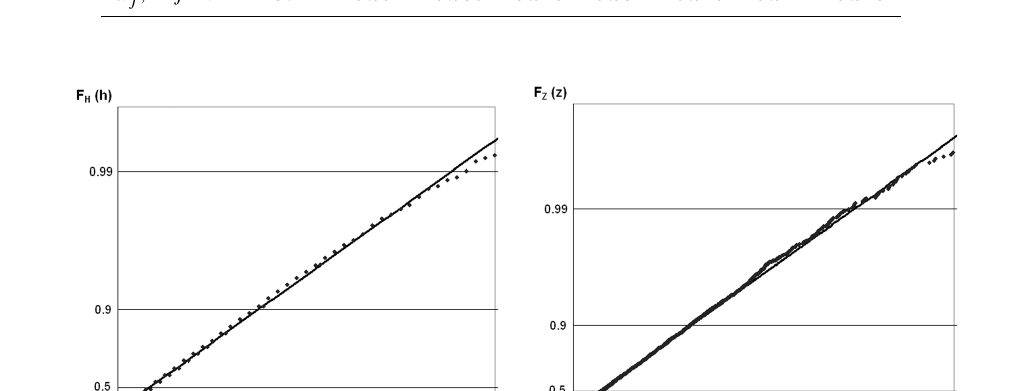
Fig. 5. Cosenza raingauge: plots on Weibull probabilistic papers of empirical and Weibull distributions for the variables (a) H i + 1 Z (ν) > 0; (b) Z (ν) i